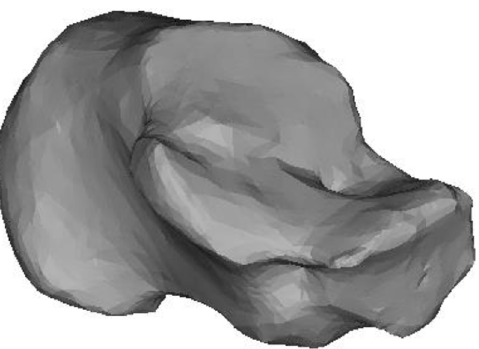
Figure 6. CT image of the foot–sagittal plane.